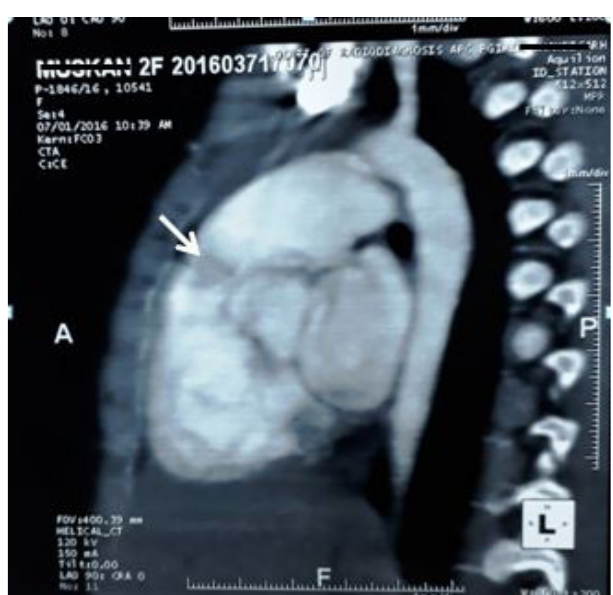
Fig. 1 - Computer tomography showing right ventricular outflow tract mass.